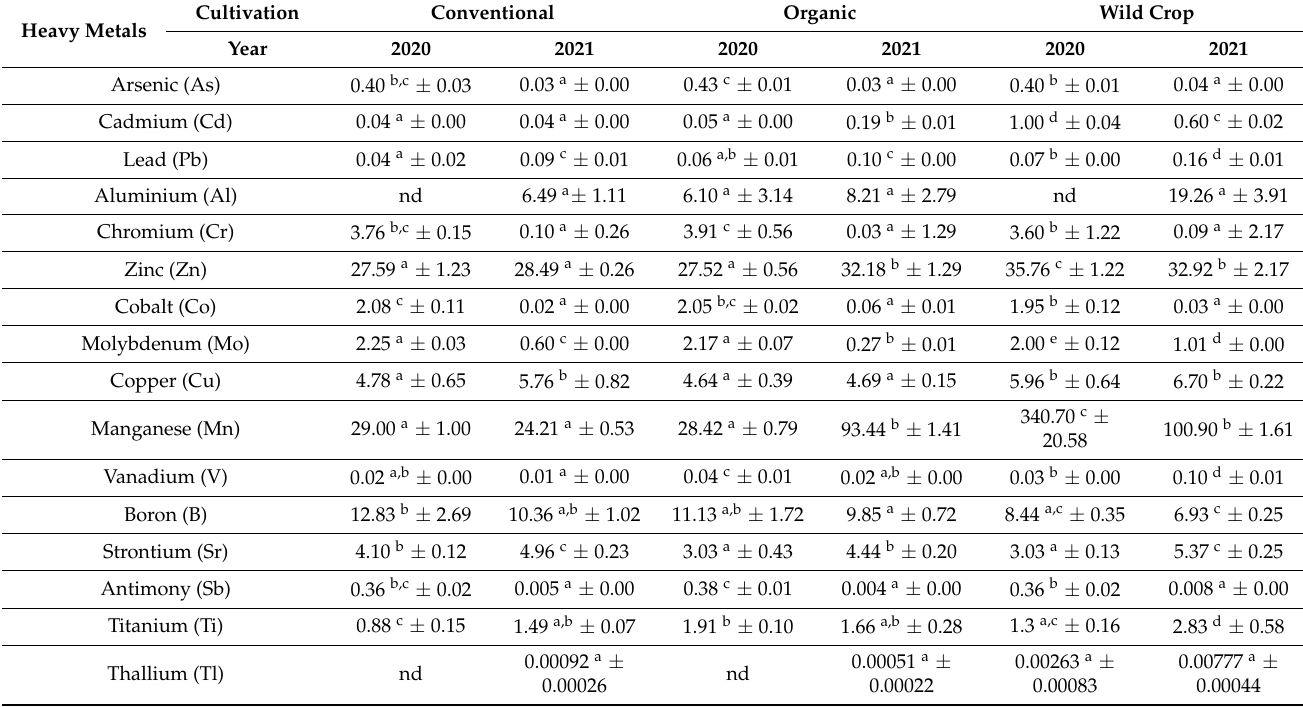
Table 1. The content of selected heavy metals in raspberry fruits from organic, conventional and wild plants (mg kg − 1 dry